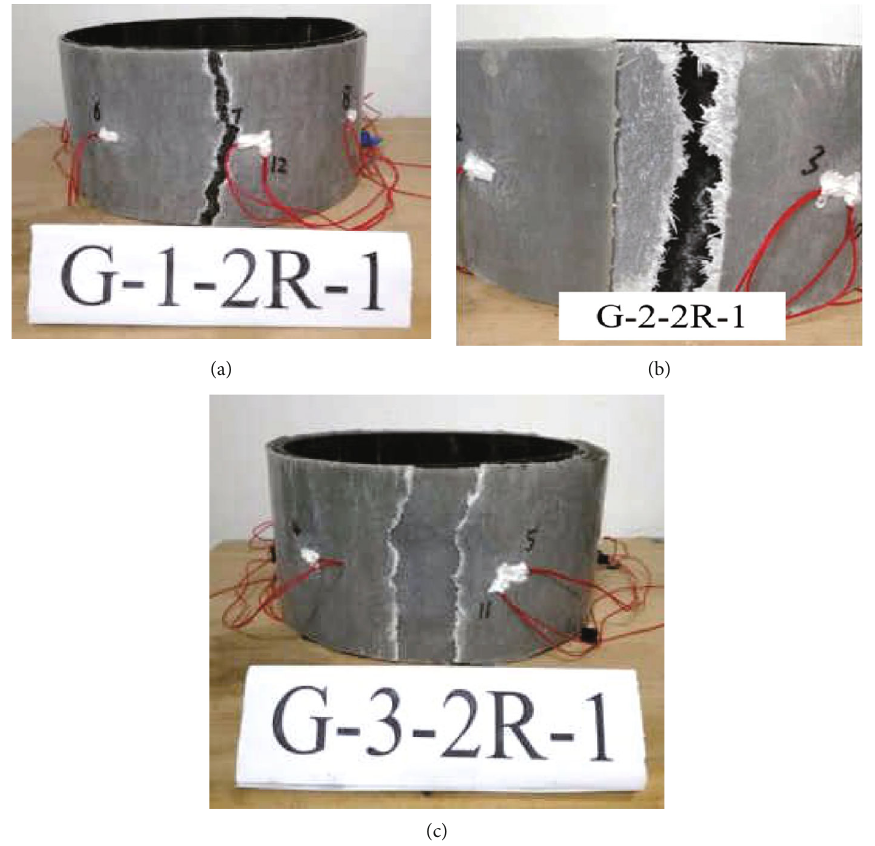
Figure 14: Failure modes of 2-layer rubber belt test